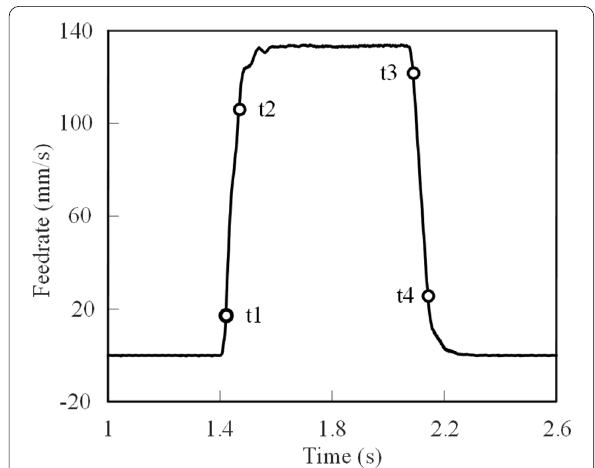
Figure 8 S type acceleration and deceleration process